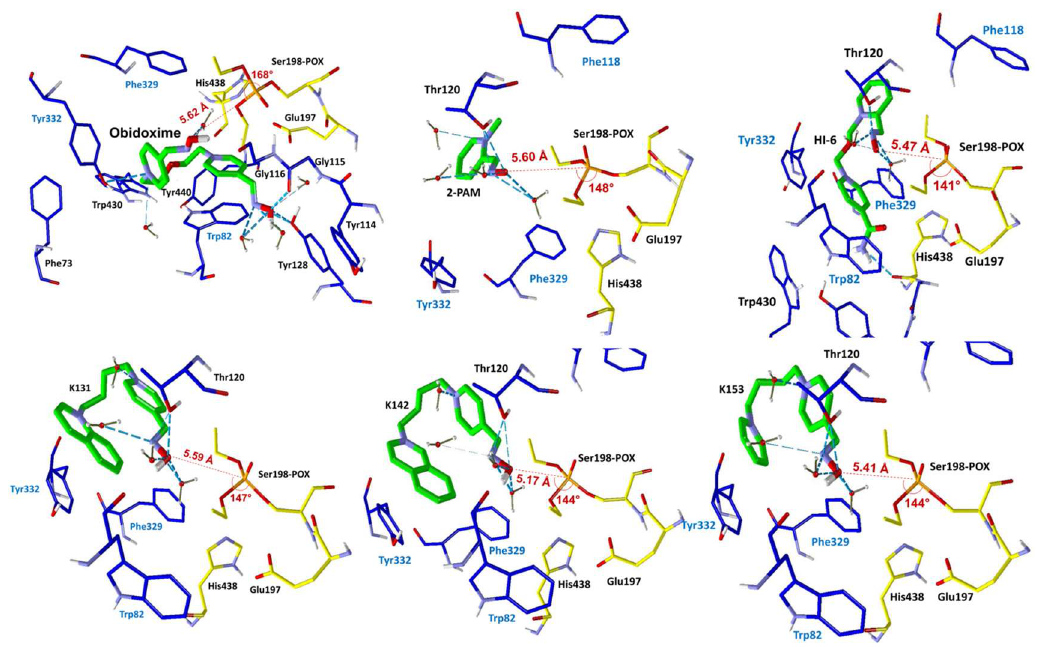
Figure 5. Best poses of the oximes inside the complex Hss BChE/POX. Distances P OP − O Ser203 and angles O ox − P OP − O Ser203 are shown in red. Molecules 2018 , 23 , x FOR PEER REVIEW